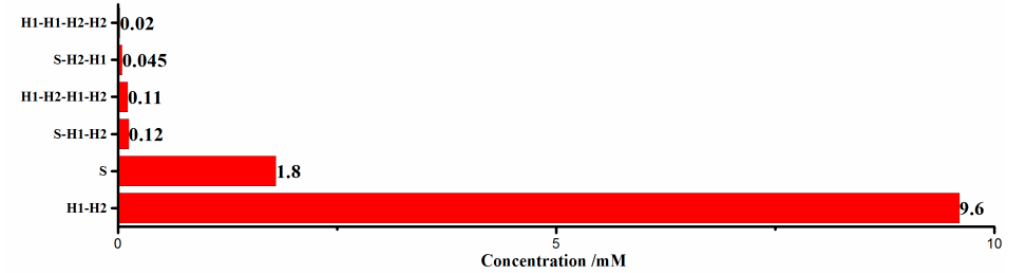
Figure 3. Simulation results of the catalyzed hairpin assembly (CHA) process in our strategy.